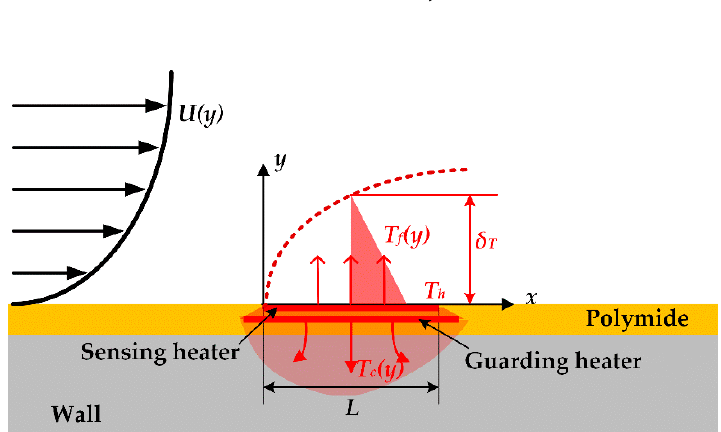
Figure 1. The working principle of the dual-layer hot film sensor.